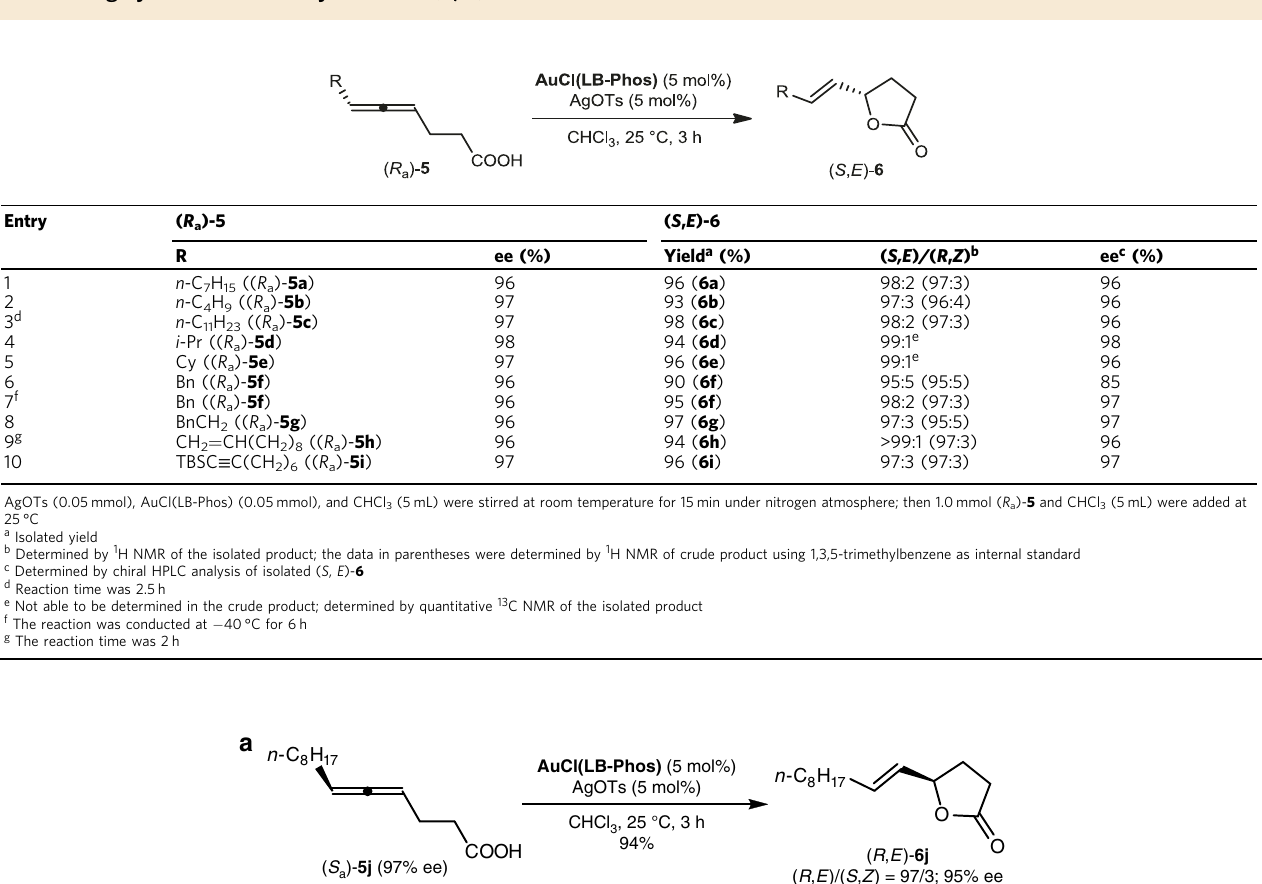
Table 2 Highly stereoselective synthesis of ( S , E )-6